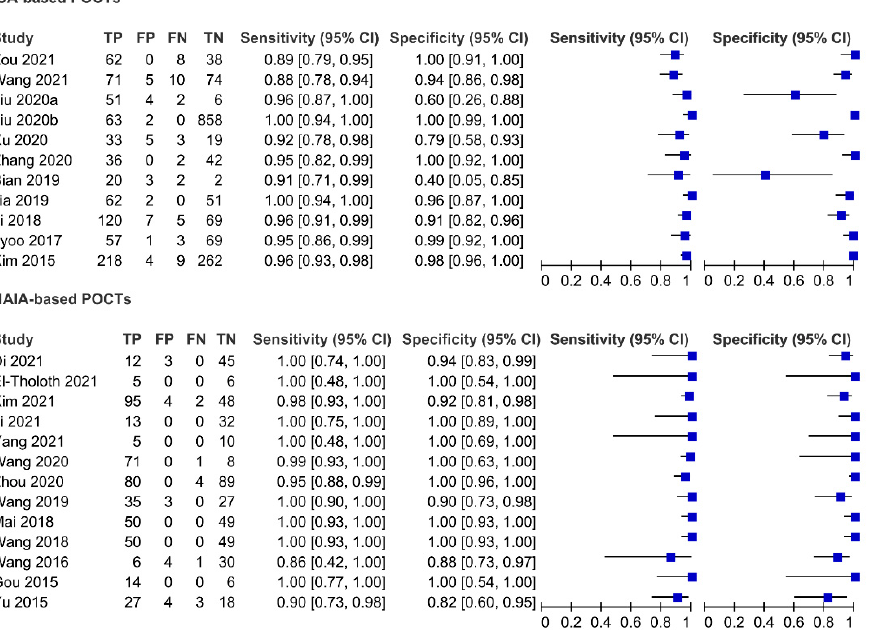
Figure 3. Forest plots of summary sensitivity and specificity of ICA- and NAIA-based POCTs in diagnosis of PEDV. Numbers are pooled estimates with 95% confidence intervals (CIs) in brackets. Table 2. Summary estimates of the diagnostic accuracy of ICA- and NAIA-based POCTs used to detect